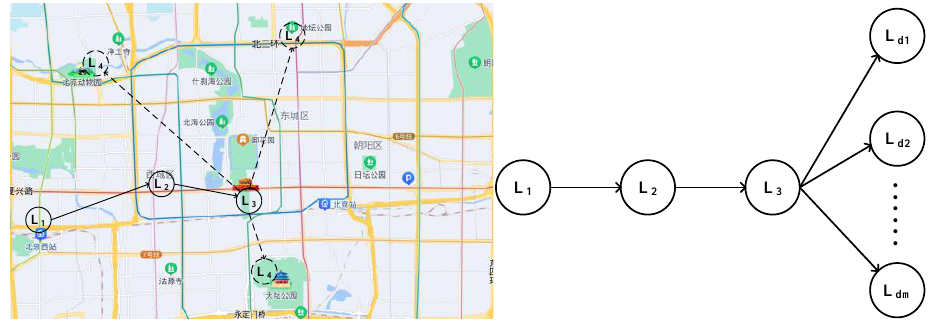
Figure 3. The choice for the next location.